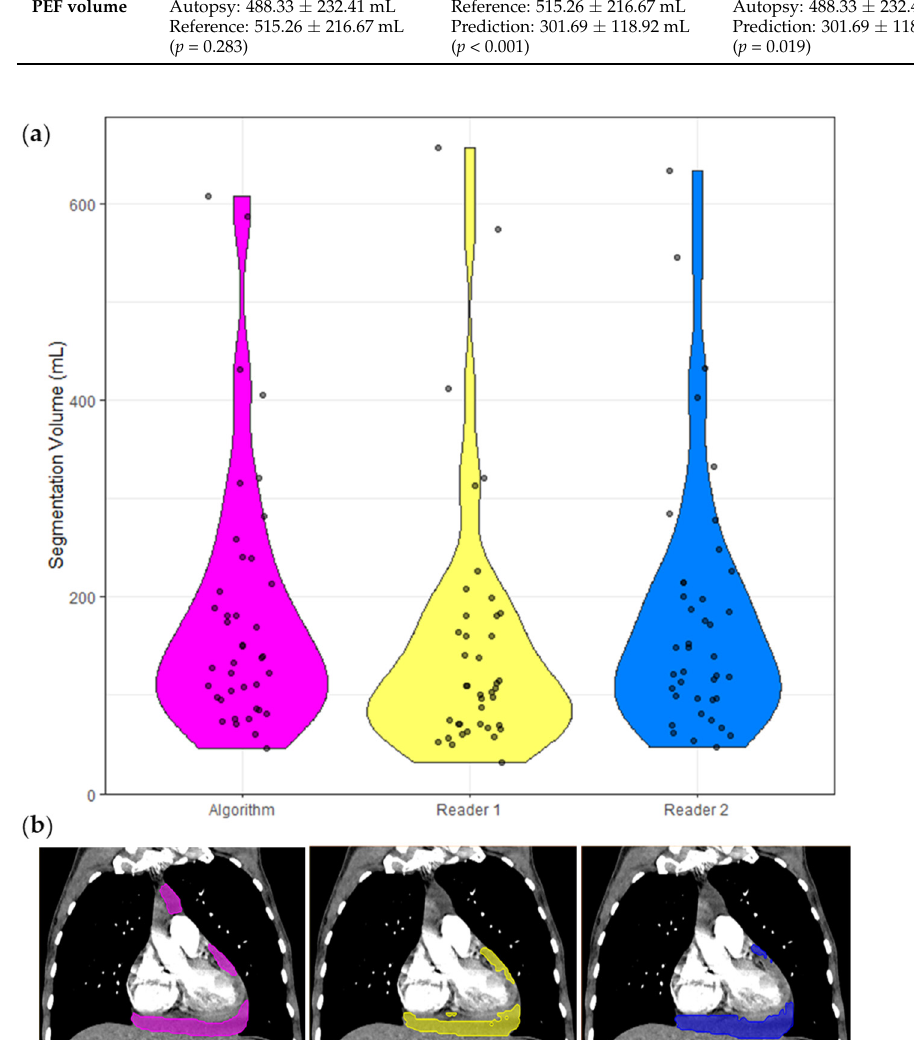
Figure 6. Segmentation volumes and a corresponding example CT with segmentation masks. ( a ) Violin plots of the volumes of the 22 cases in the external dataset. Each violin plot is color coded to match the corresponding volume calculation in ( b ). Pink = Model, gray/no mask = Autopsy, yellow = Reference. ( b ) PMCT in soft tissue windowing of a hemopericardium with aortic dissection. The model segmented 257 mL, the volume extracted at autopsy was 350 mL and the Reference segmented 290